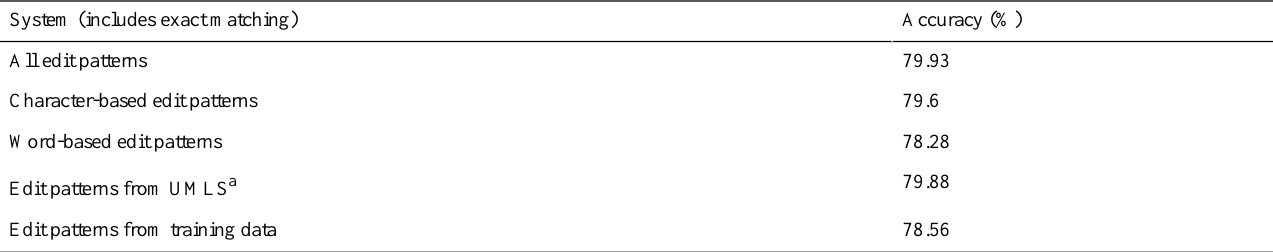
Table 3. Results of the ablation study for the method using different types of learned edit patterns.